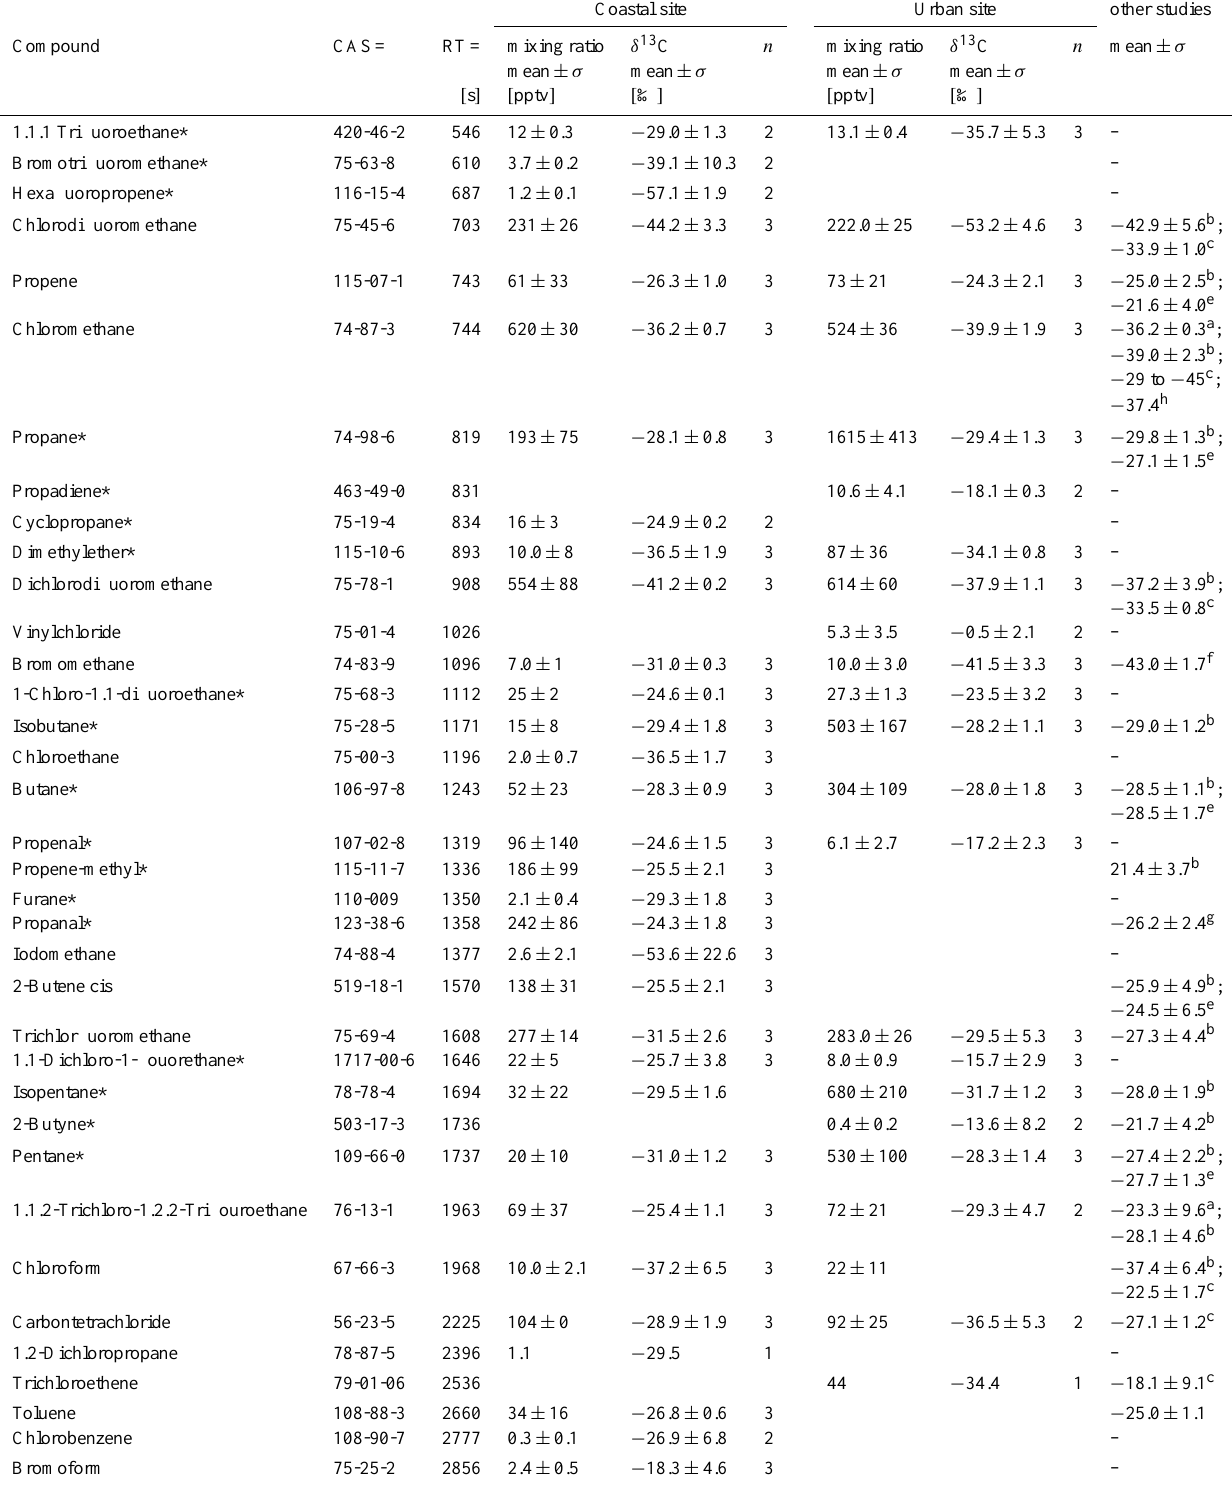
Table 2. Averaged concentrations and isotopic values for all compounds reported in this paper from the coastal and the urban sampling site. Coastal